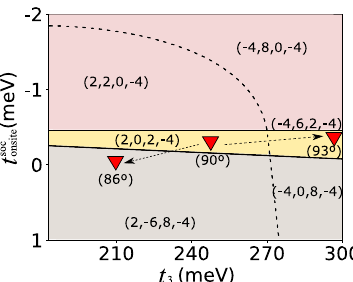
Fig. 8 Change of the Chern number of each band with respect to hopping parameters in tight-binding model. t 3 and t soc 3 rd NN hopping and onsite SOC term, respectively. The four integer pair ( i 1 , i 2 , i 3 , i 4 ) represent the Chern number of each band. DFT calculations with three different structures which have distinct Cr – Te – Cr angles (X ∘ ) was also performed, and the corresponding parameter values extracted from the Wannier function analysis are makerd with red triangle.